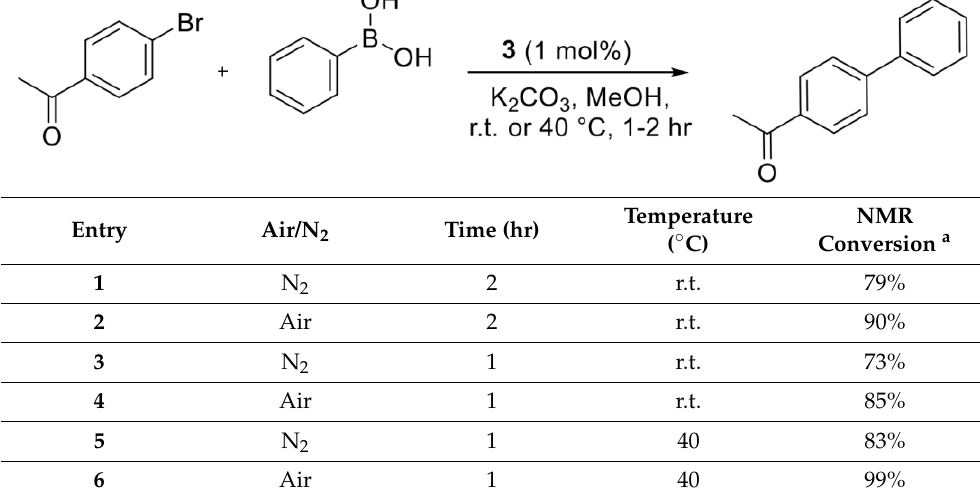
Table 1. Initial optimization studies carried out between 4 – bromoacetophenone and phenylboronic acid.